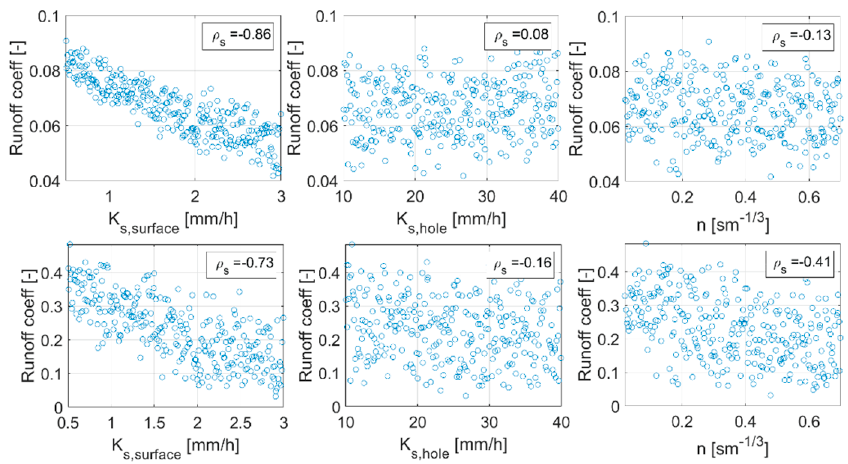
Figure 4. Correlation between runoff coefficient and input parameters for HM 30 (first row) and PP 20 (second row). (cid:2025) (cid:3046) is the Spearman’s correlation coefficient between the couple of datasets.